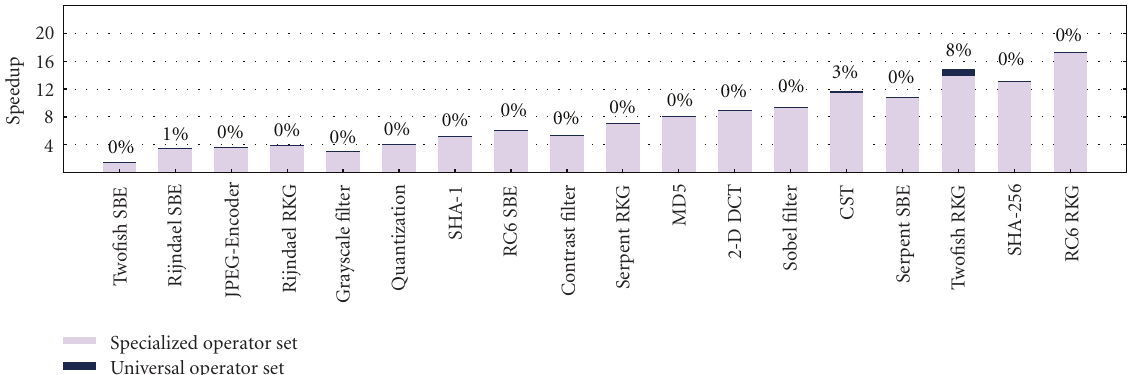
Figure 14: Speedup of Benchmark Applications on a Specialized 8 Operator Array With 3 Multiplication Operators and 1 Division Operator and Dual Ported Memory Acccess.